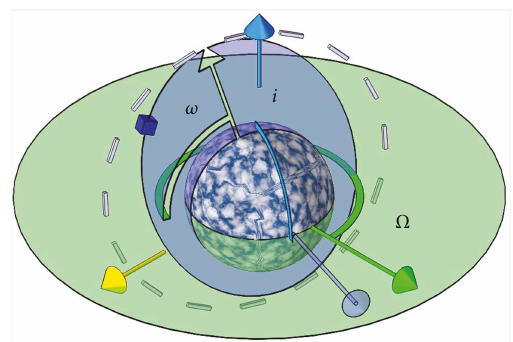
Figure 10: Six parameters are needed to establish a full orbital description of a satellite. However, for the Sun-synchronous orbits, a good approximation using just one parameter exists. The illustration shows the three Euler angles ( ω , Ω , and i ) and an Earth-centered “ Sun- fi xed ” reference coordinate system. Orbit eccentricity, mean motion, and mean anomaly are not directly indicated. The yellow Sun-Earth pointing vector fi xes both time on Earth and the orbital reference coordinate system. Thus, by using satellite pass start time, it is possible to relate a pass to a given deterministic trajectory and thereby recreate the position of the satellite during a given beacon transmission, see Figure 12. The green vector is the vernal equinox